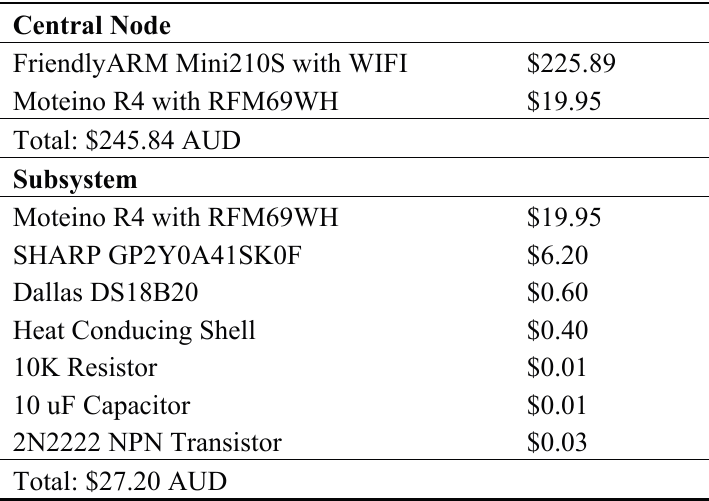
Table 1. The cost of the elements used in this